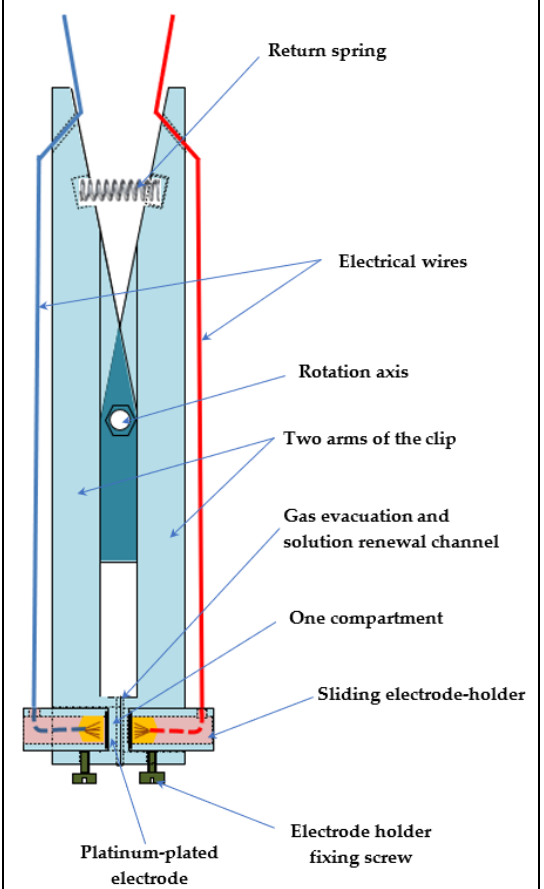
Figure 13. LMEI Clip to measure the ion-conductivity of membranes.